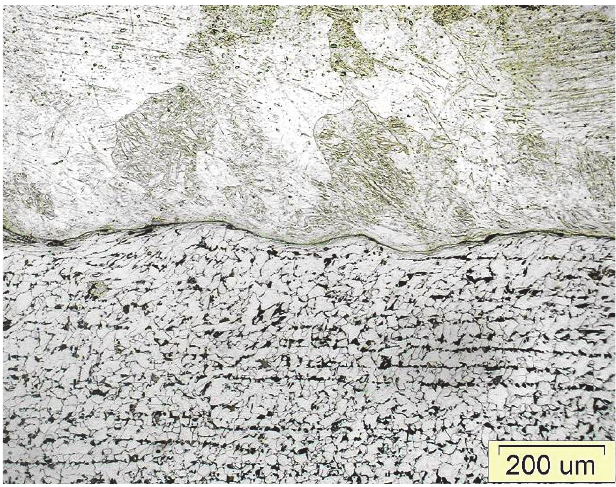
Figure 1: The microstructure of zirconium-steel joint without melted